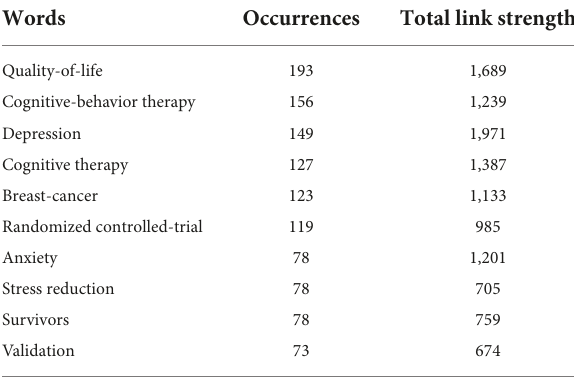
TABLE 6 Top 10 frequent words in the research scope of cognitive behavioral therapy and